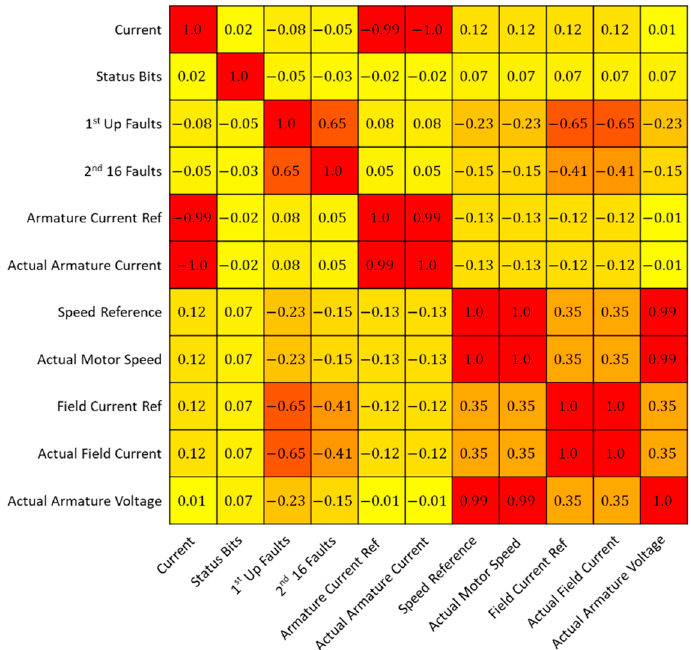
Figure 3. Correlation matrix to test relationships between incoming sensor signals. The colours represent the strength of the correlation, with red representing the strongest relationship regardless of positive or negative, and yellow the weakest relationship.